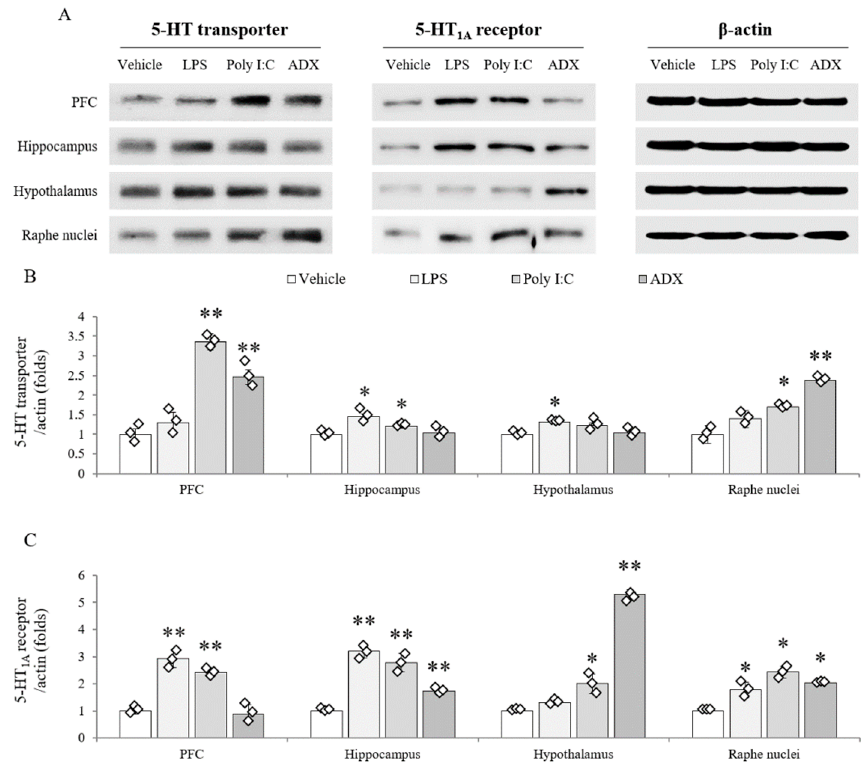
Figure 5. Serotonergic transporter and receptor expression in brain regions. The 5-HT transporter and 5-HT 1A receptor protein expression in brain regions ( A ). Quantification of 5-HT transporter ( B ) and 5-HT 1A receptor expression ( C ). Data are expressed as the means ± SD ( n = 6). *, p < 0.05; **, p < 0.01 compared with the vehicle group.